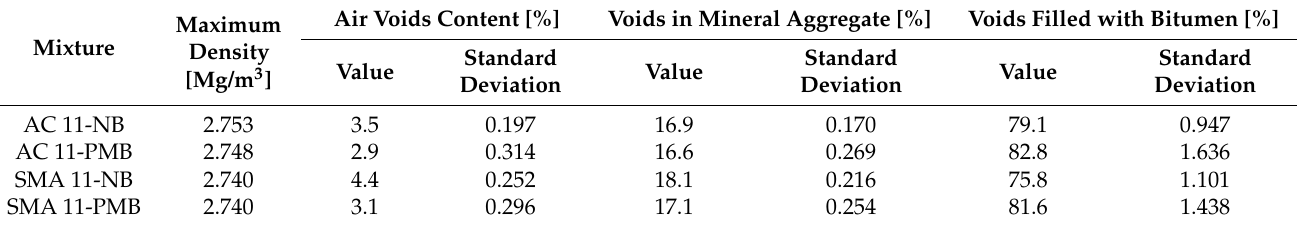
Table 4. Maximum density and void characteristics of specimens.